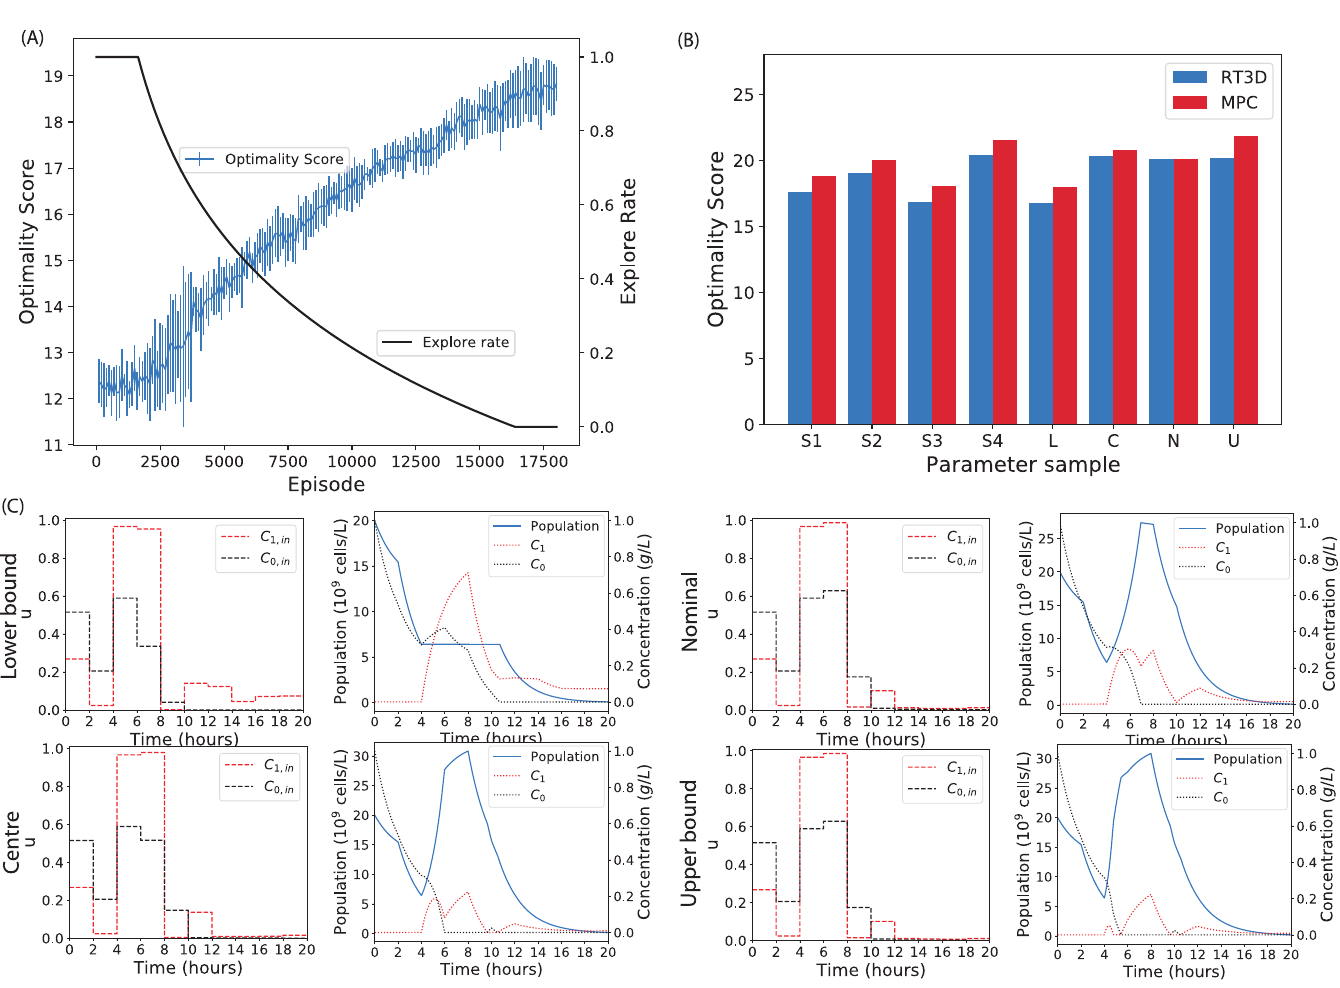
Fig 4. The RT3D algorithm trained over a parameter distribution. (A) Average training progress and shared explore rate of ten Recurrent T3D agents over 17500 episodes. For each episode the model parameters are sampled from a distribution. This was then averaged across the 10 repeats. Error bars indicate one standard deviation. (B) The optimality score of the best performing agent in panel A compared to an MPC with a priori parameter knowledge for different parameter samples. Four randomly sampled parametrisations, S1, S2, S3 and S4 are shown along with the lower and upper bounds of the parameter space, L and U, the nominal parameters from literature, N, and the centre of the distribution, C. (C) The experimental designs of the RT3D controller at different parameter samples. Here the RL controller is trained on a distribution over parameters and adapts its experimental design for different points in parameter space. For each experimental design the system is initialised with different parameter values: L, U, N and